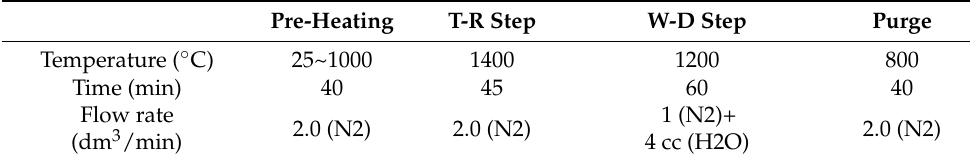
Table 2. Experimental conditions of the two-step water-splitting cycle with reactive foam device using 3 kW th sun-simulator.